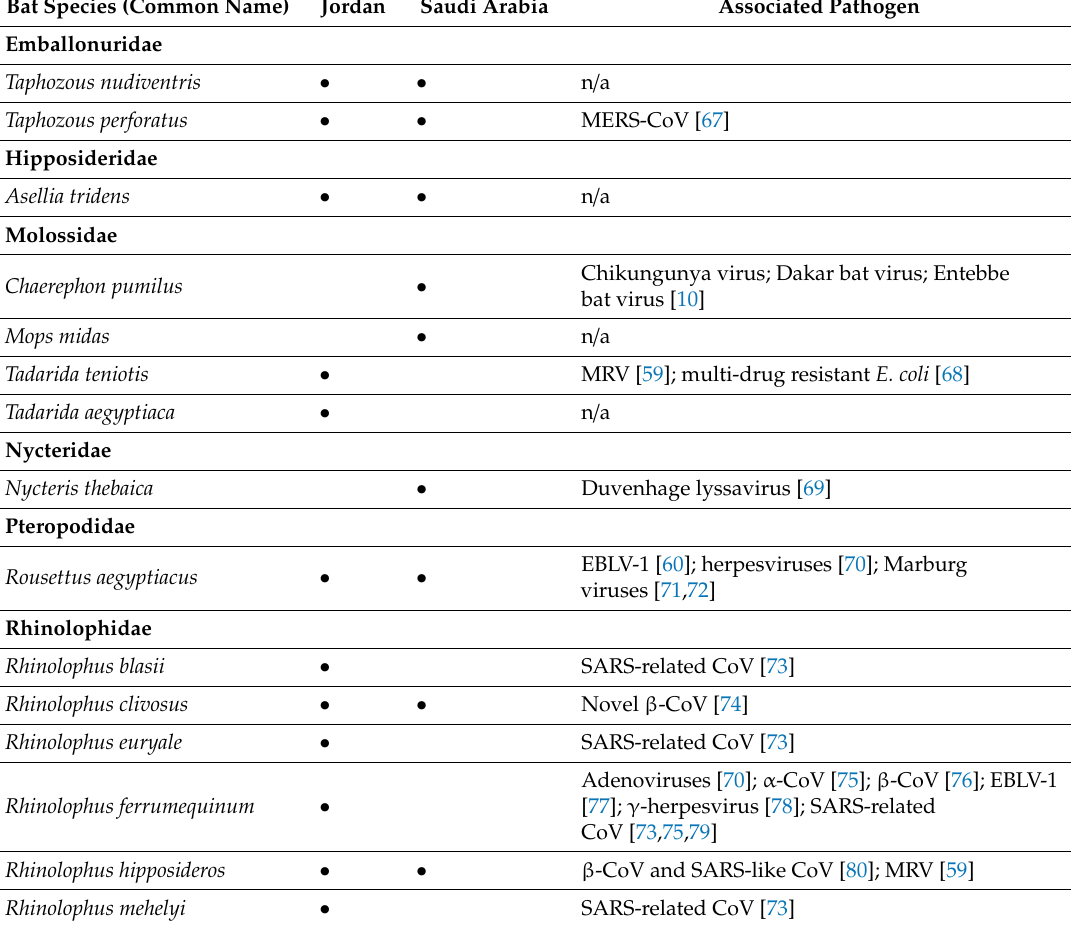
Table 1. Bat species native to Jordan and Saudi Arabia along with their worldwide associated pathogens. A dot indicates that this bat species has been recorded in the